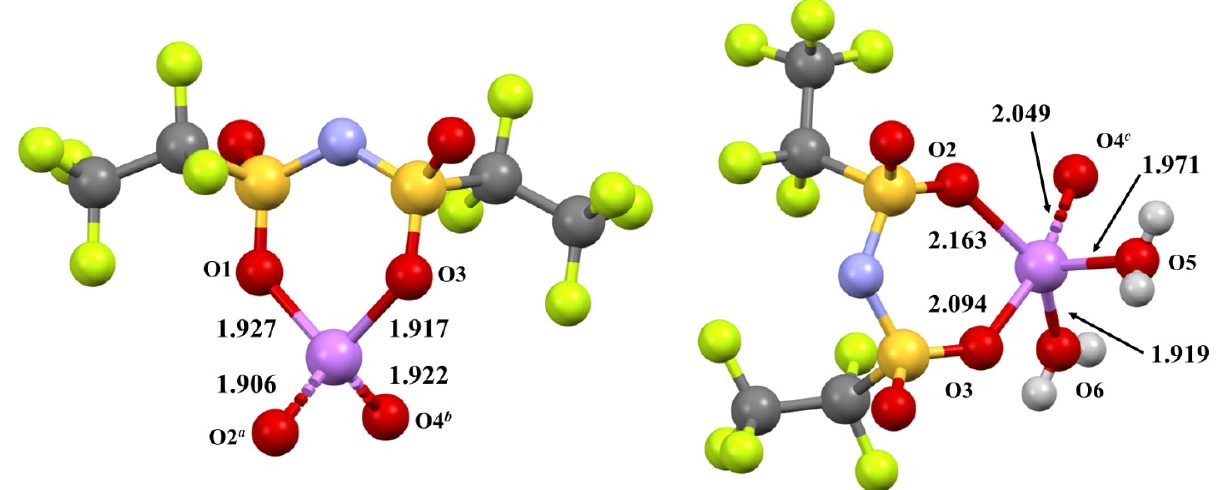
Figure 3. Images depicting the lithium cation coordination geometry for [Li{BETI}] ( left ) and [Li{BETI}(H 2 O) 2 ] ( right ). Bond distances are shown in Å. Dashed bonds indicate symmetry adjacent atoms. a = +x, − y, ½ + z; b = +x, − 1 + y, +z; c = − 1 + x, +y, +z.